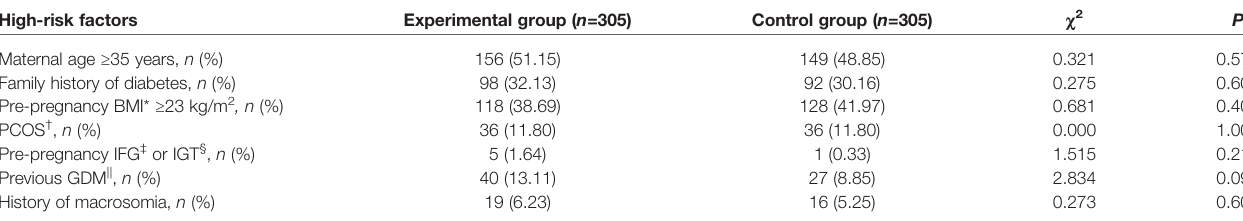
TABLE 1 | Comparison of high-risk factors between the experimental and control groups. High-risk